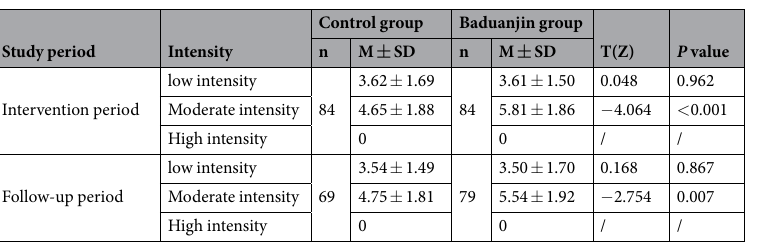
Cardiac Structure, Cardiac Function and Static Pulmonary Function. We found no significant dif- ferences in all parameters of cardiac structure and function and static pulmonary function, including left atrial diameter, right ventricular diameter, left ventricular ejection fraction, minute ventilation volume, vital capacity and maximal voluntary ventilation, between the Baduanjin exercise group and the control group, whereas a sig- nificant interaction of group by time was also not identified by the mixed linear model analysis (Table 4). Traditional Risk Factors of Cerebrovascular Diseases. A significant main effect of group and interac- tion effect of group by time in the plasma risk factors including the total cholesterol (TC), triglyceride (TG), low density lipoprotein (LDL-C), high density lipoprotein (HDL-C), fasting blood glucose (FBG) and homocysteine (Hcy) was not observed (Table 5). Among the four measured anthropometric measurements, including body mass index (BMI), waist circum- ference (WC), hip circumference (HC) and waist/hip ratio, the mixed linear model showed a significant interac- tion of group by time and main effect of group on WC, HC and the waist/hip ratio; three (WC, HC and the waist/